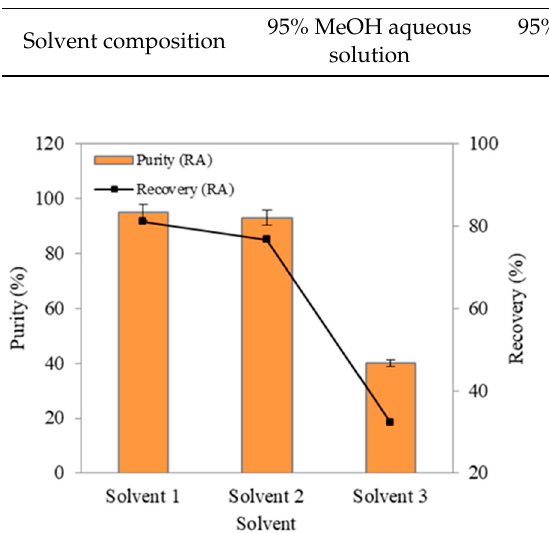
Figure 2. Solvent effect on purity and recovery of RA.